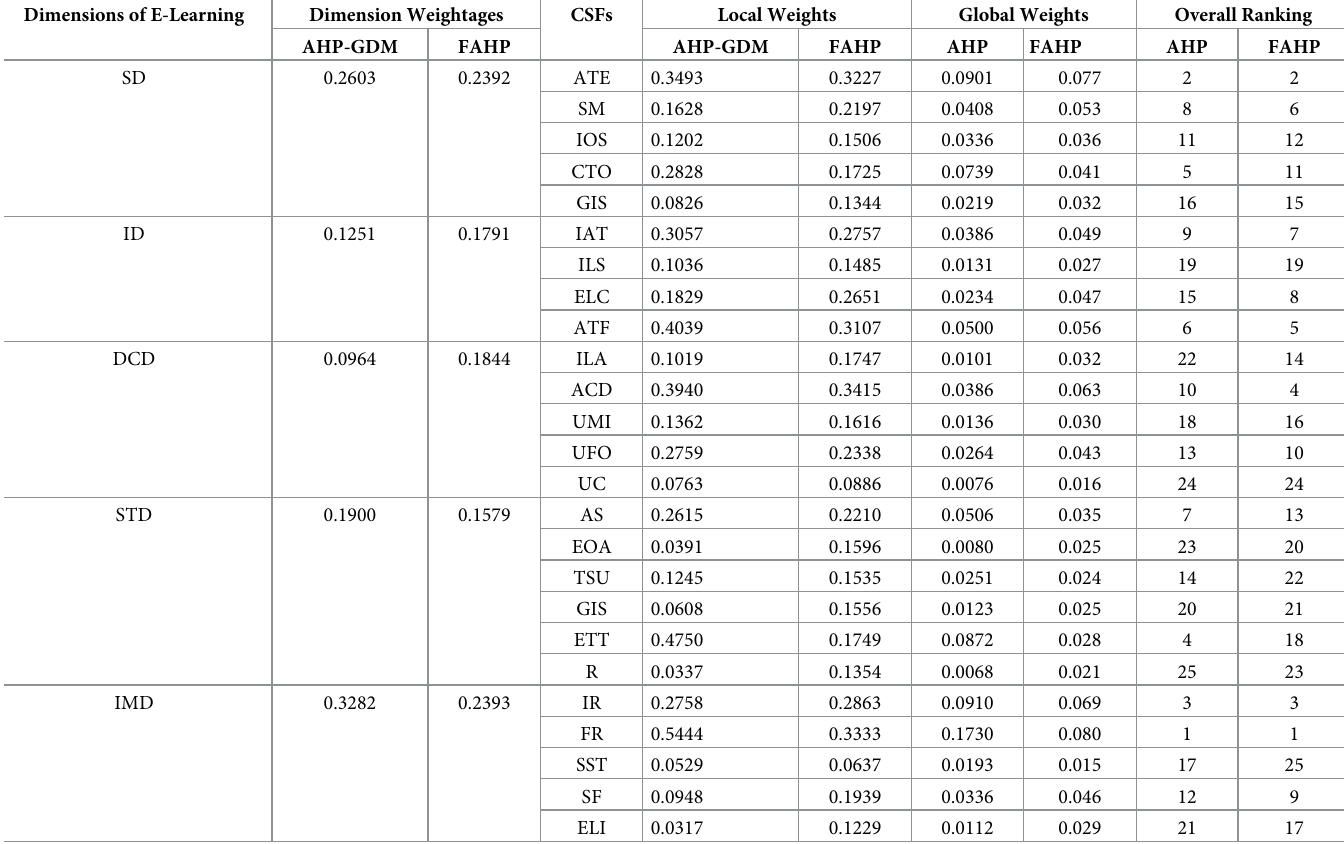
Table 13. A comparison of composite weights and rank of dimension and CSFs of E-Learning using AHP-GDM and FAHP. Dimensions of E-Learning Dimension Weightages